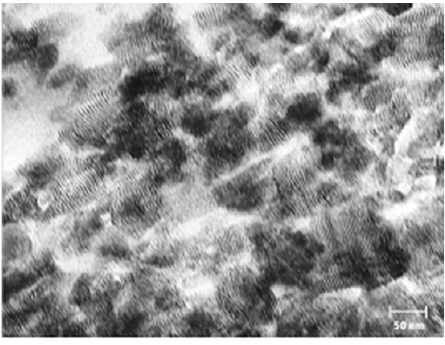
Figure 7. TEM image of a ZnAl-PyH-LDH. Source: Tronto (2006).